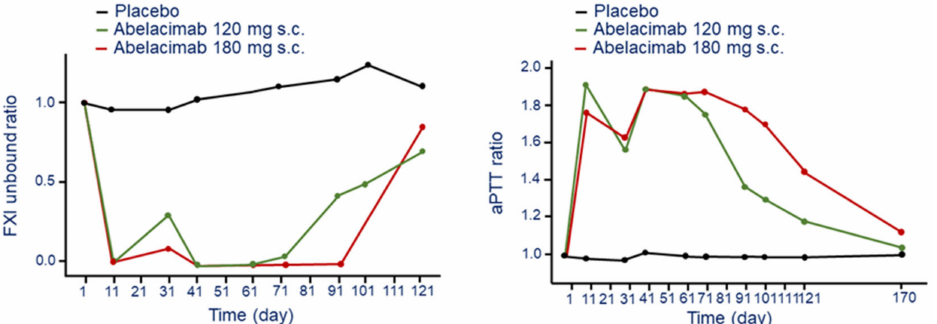
Figure 1. Time and dose-dependent effect of abelacimab on bound FXI ( left panel ) and aPTT ( right panel ) following monthly s.c. administration. Ratios were calculated by dividing by the subject’s baseline values. Modified from Yi A.B. et al. [22]. F: factor; aPTT: activated partial thromboplastin